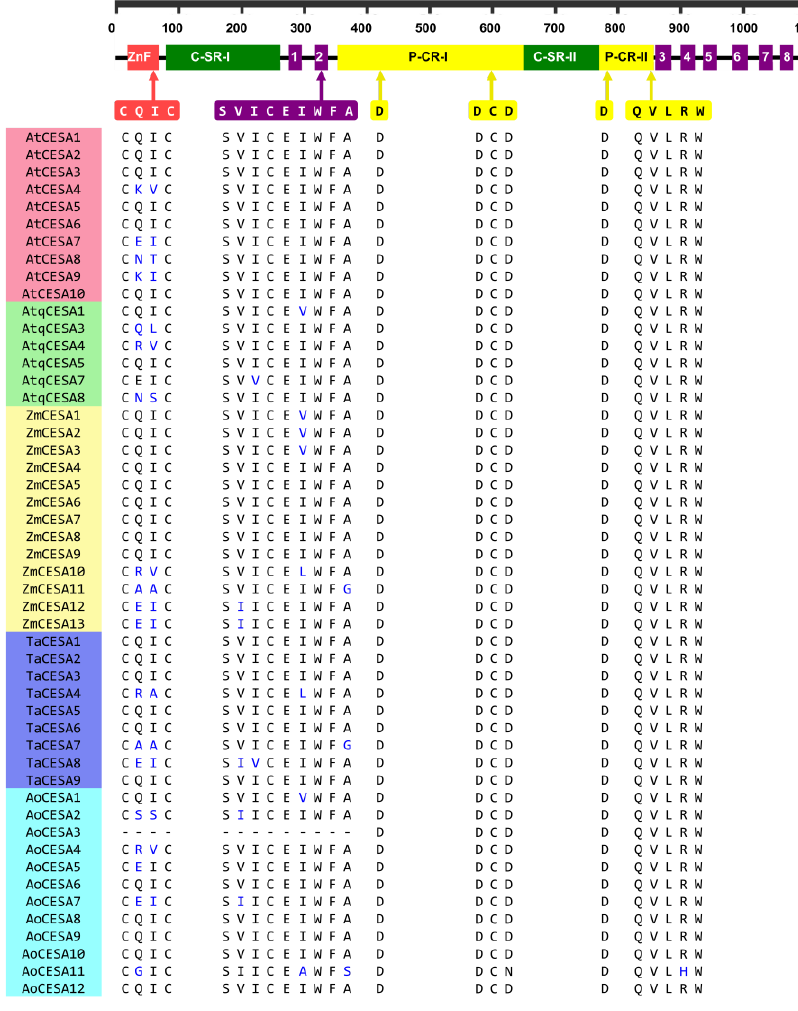
Figure 3. Motif alignment of AtqCESAs with CESAs from other species. Arabidopsis thaliana (AtCESA), Agave tequilana (AtqCESA), Zea mays (ZmCESA), Triticum aestivum (TaCESA), and Asparus officinalis (AoCESA). Non-conserved residues are highlighted in blue.